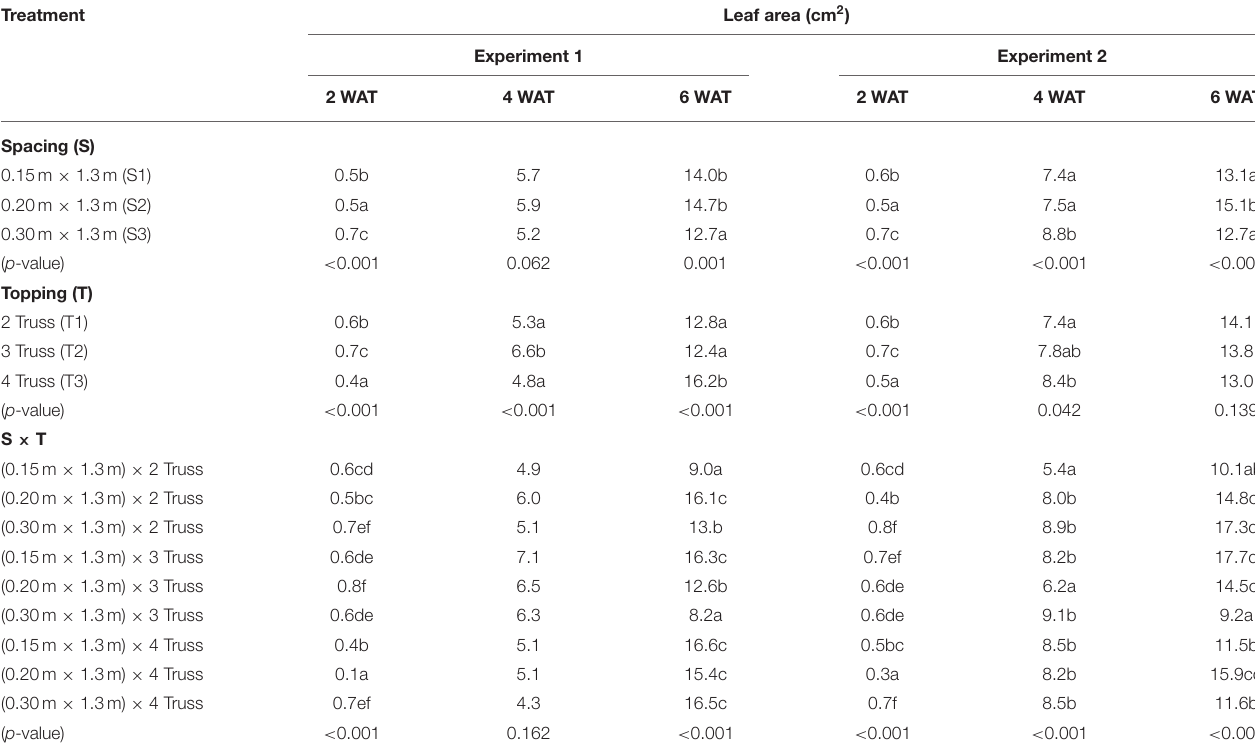
TABLE 7 | Effect of spacing and topping on leaf area of Solanum lycopersicum under greenhouse conditions. Treatment